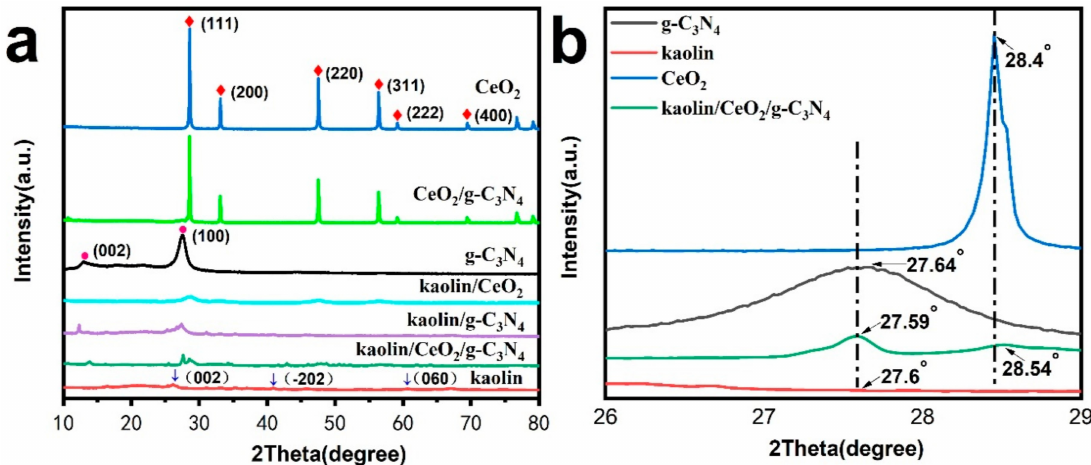
Figure 1. ( a ) XRD patterns of kaolin, CeO 2 , g-C 3 N 4 , kaolin / CeO 2 , kaolin / g-C 3 N 4 , CeO 2 / g-C 3 N 4 and kaolin / CeO 2 / g-C 3 N 4 composite, ( b ) the corresponding enlarged area marked with dashed lines in Figure